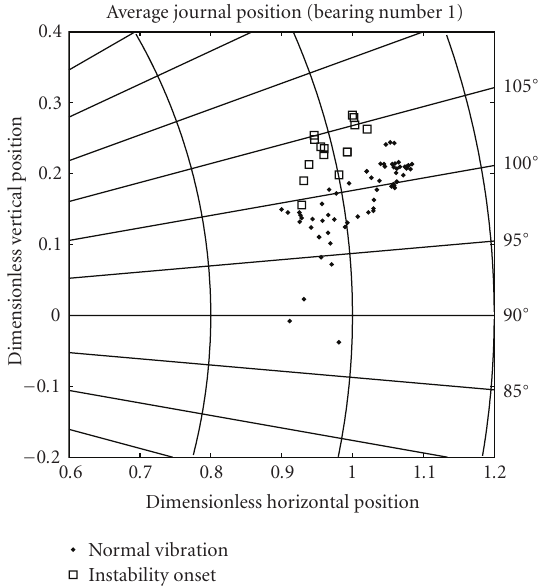
Figure 12: Polar plot of the dimensionless journal position of bearing no. 1 measured during a four-day time interval within which two oil-whip instability onsets occurred.